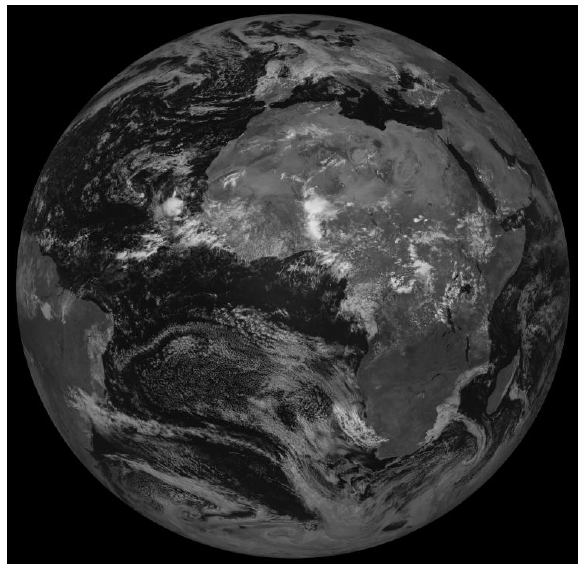
Figure 1. Example of a Meteosat image in visible channel, taken on 7 September 2010, at 1200 UTC. Reflectance increases from black to white. The area covered is the same for Meteosat First and Second Generations. (Copyright Eumetsat,